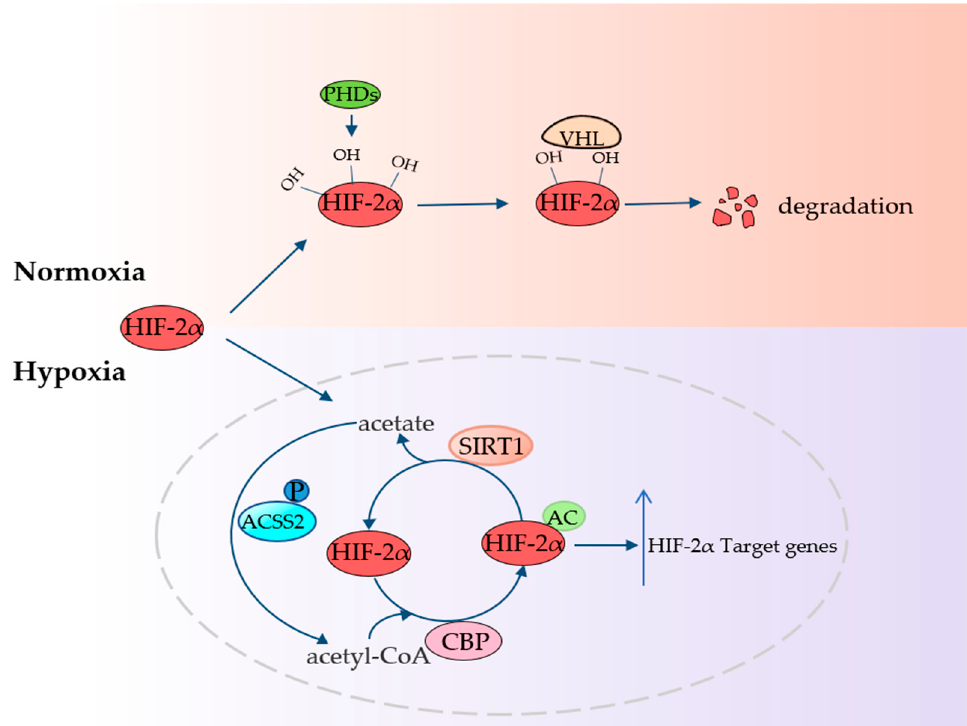
Figure 4. ACSS2 fights hypoxia HIF-2 α can be hydroxylated by PHD under normoxic condition, and then degraded by VHL. ACSS2 can use local acetate to produce acetyl-CoA, which provides the acetyl group for selective CBP acetylation of HIF-2 α . Sirt-1 can deacetylate HIF-2 α to produce acetate. The whole process continuously promotes the expression of HIF-2 α target genes. PHD: prolyl hydroxylase.